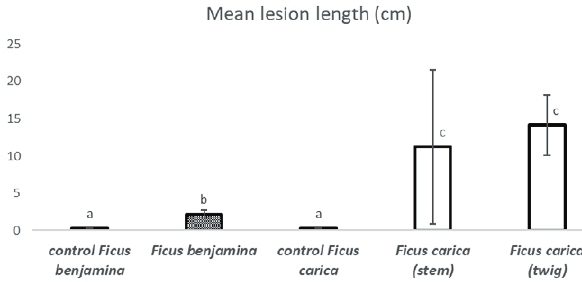
Figure 5. Mean internal lesion lengths (cm), after inoculation of Ficus carica sapling stems and branch twigs, or F. benjamina branch twigs, with Ceratocystis ficicola . Columns accompanied by standard deviations of means, and those accompanied by the same letters are not significantly different ( P ≤